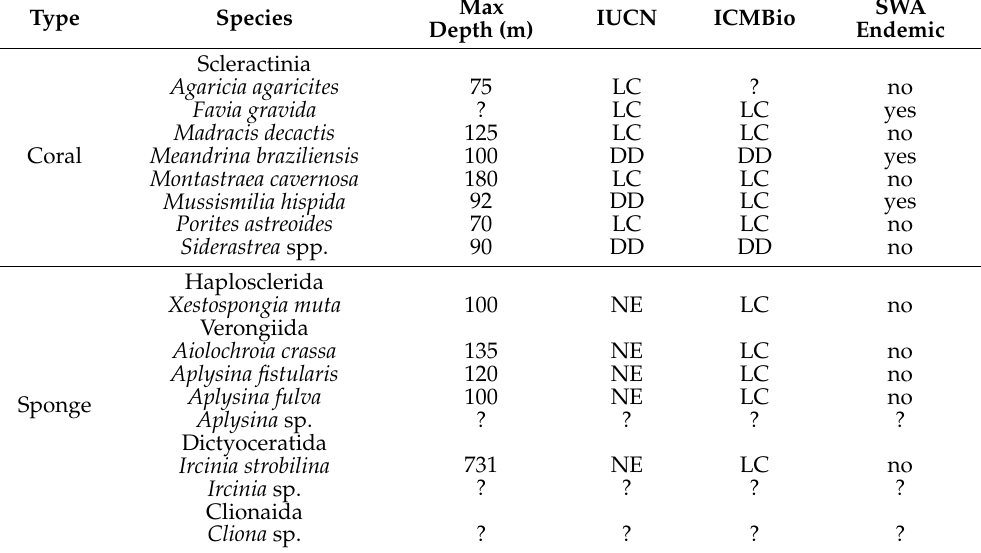
Table 1. Benthic cover record in the mesophotic zone of Marine Protected Area Costa dos Corais, Brazil. Conservation status IUCN/ICMBio: DD = Data Deficient; EN = Endangered; LC = Least Concern; NE = Not Evaluated; NT = Near Threatened; VU = Vulnerable. Geographic distribution: SWA = Southwestern Atlantic. ? = Data not